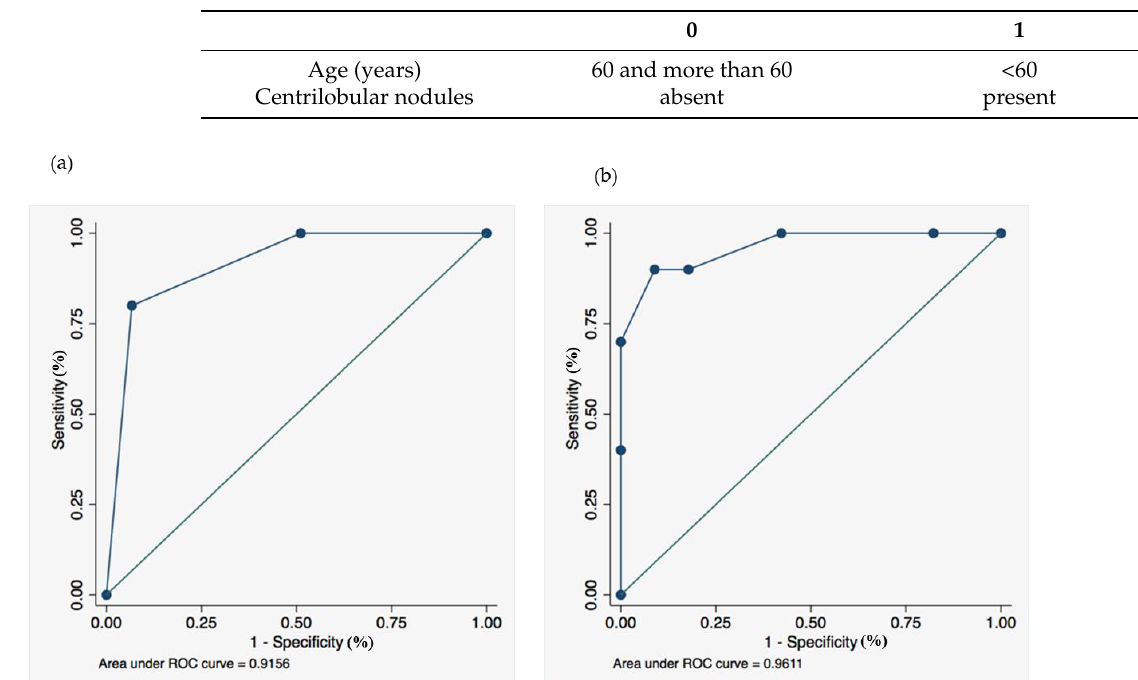
Figure 3. Receiver operating characteristic curves in ( a ) the Mycoplasma pneumoniae pneumonia-computed tomography age (MPP – CTA) scoring system and ( b ) the JRS Scoring for atypical pneumonia.